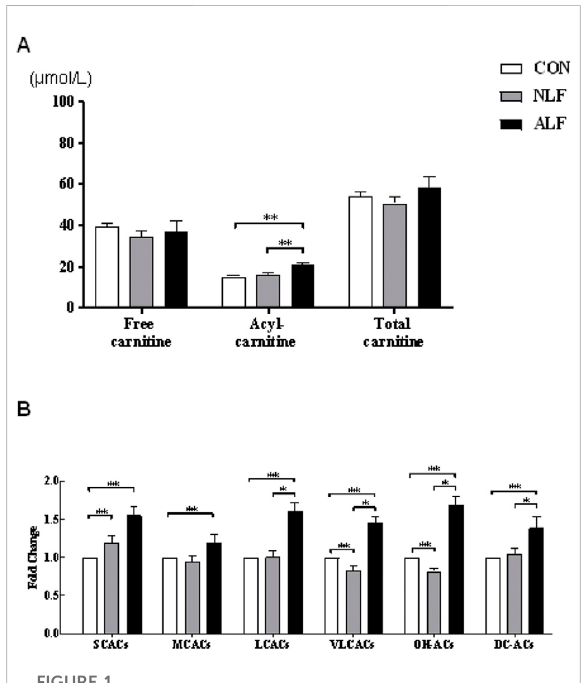
FIGURE 1 Altered ACspro fi lein threegroups ofchildren. (A) Changes in free carnitine, ACs, and total carnitine levels. (means ± SE) (B) Changes in the levels of different types of ACs. (means ± SD). *p < 0.05, **p <